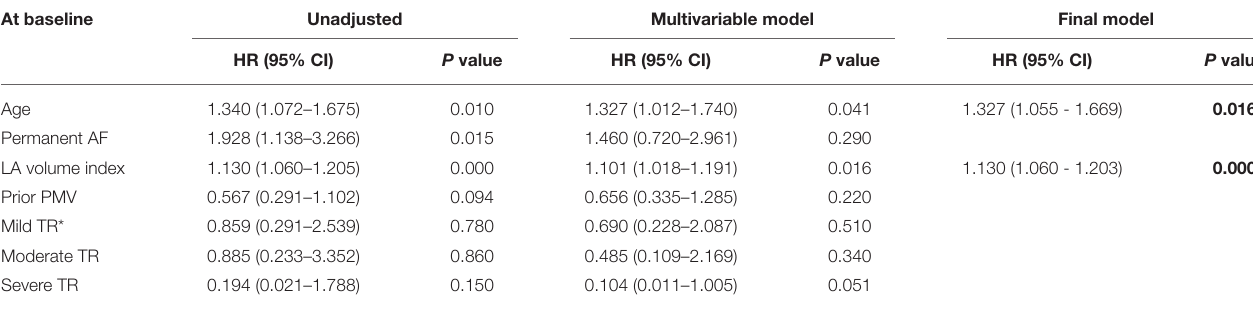
TABLE 4 | Clinical and echocardiographic characteristics associated with MR progression in patients with RHD: Fine-Gray model. At baseline